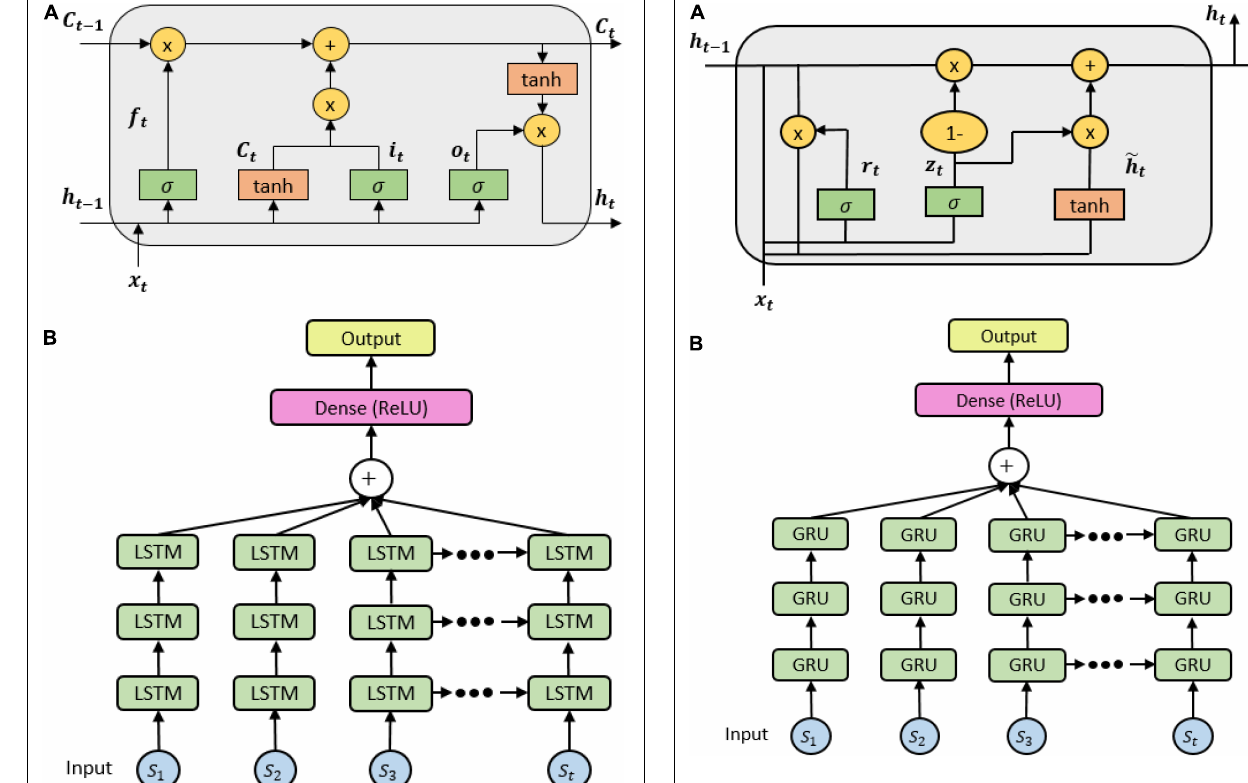
FIGURE 3 | (A) A gated recurrent unit (GRU) cell internal mechanism; (B) the stacked GRU